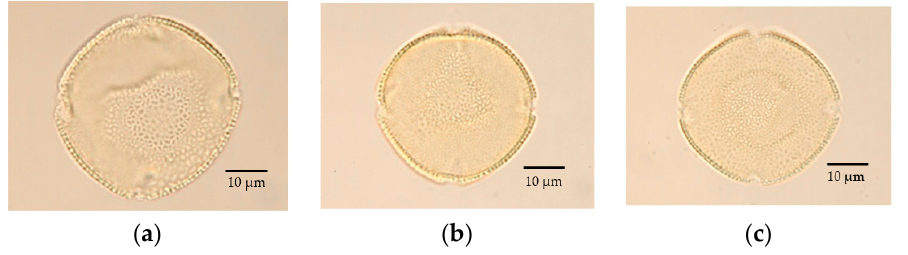
Figure 7. Pollen morphology of Fraxinus platypoda in polar view. ( a – c ) Pollen grains from a male flower of a male tree ( a ), a male flower of an andromonoecious tree ( b ), and a hermaphroditic flower of an andromonoecious tree ( c ).